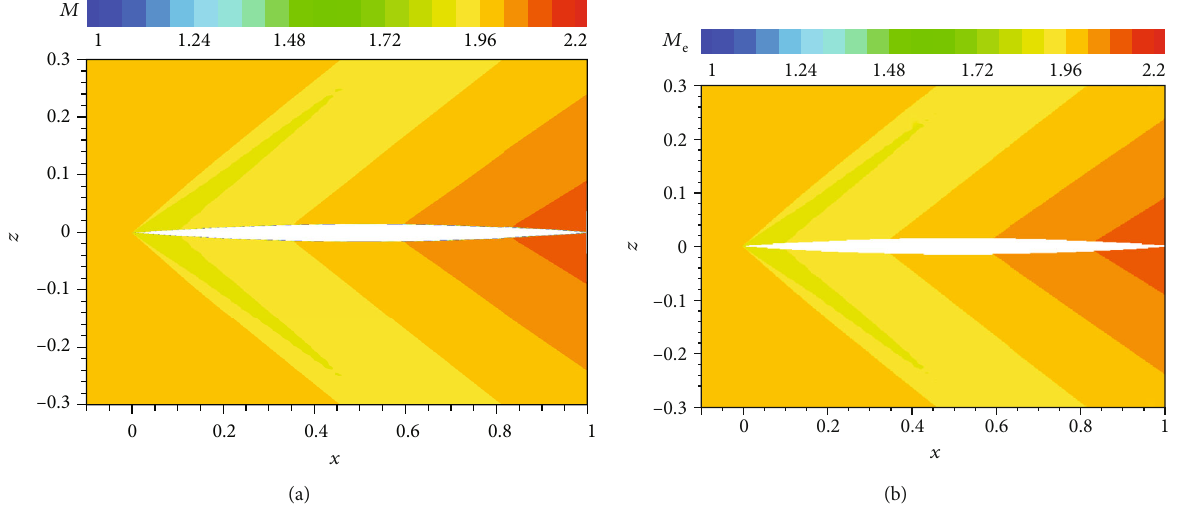
Figure 9: Comparison between (a) local Mach number and (b) predicted M